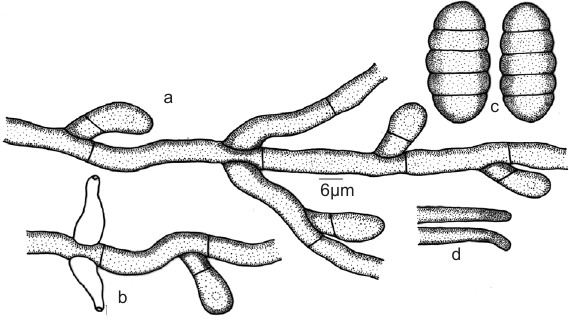
Figure 2. Irenopsis kleinhoviae sp. nov. a - Appressorium; b - Phialide; c - Ascospores; d - Apical portion of the perithecial setae